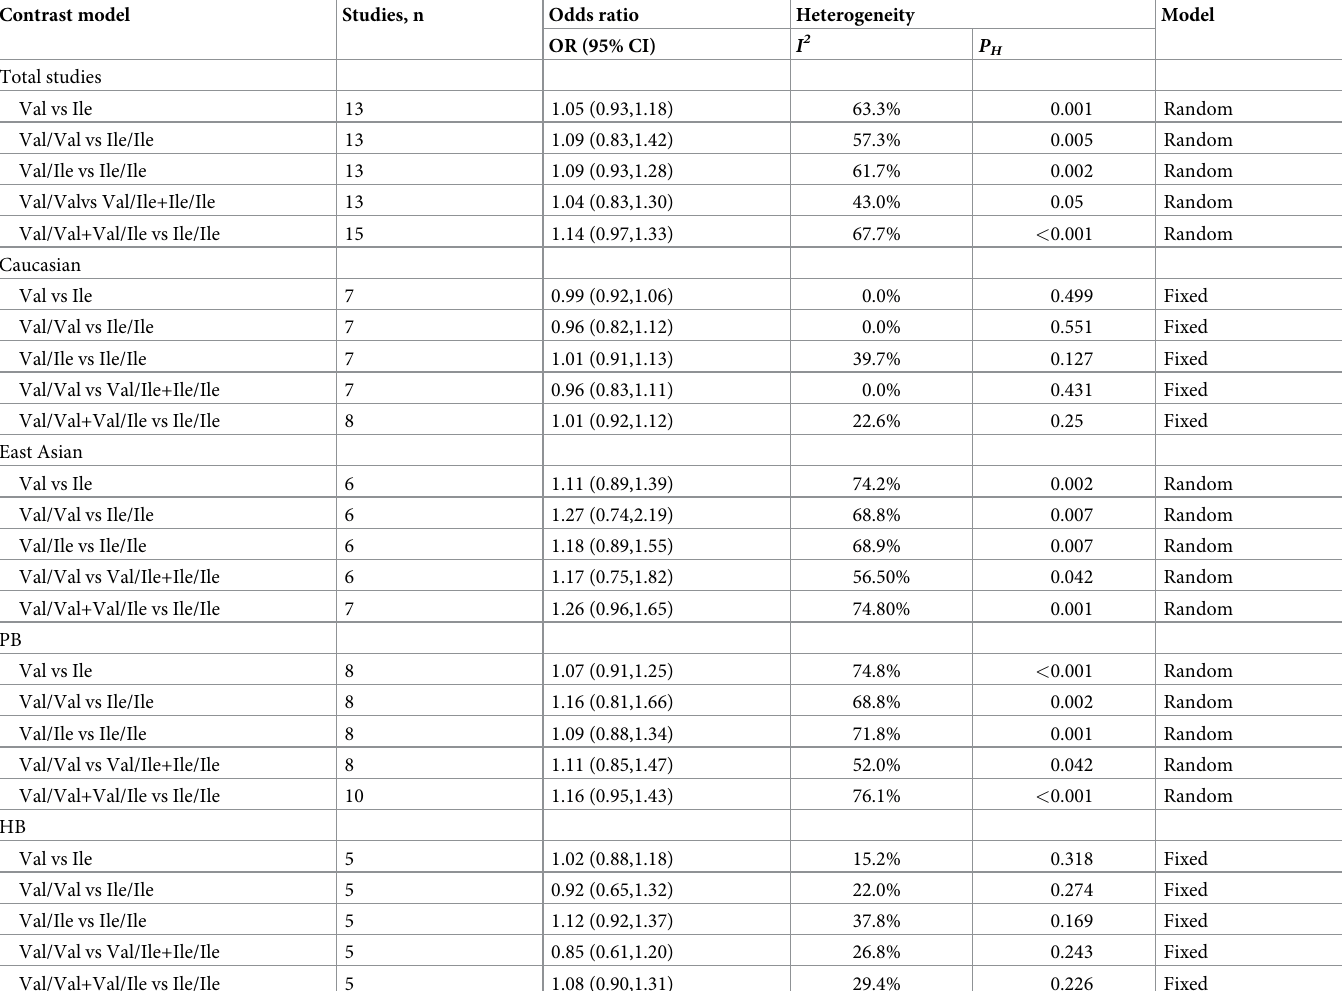
Table 2. Summary ORs and 95% CIs of the association between GSTP1 Ile105Val polymorphism and CHD